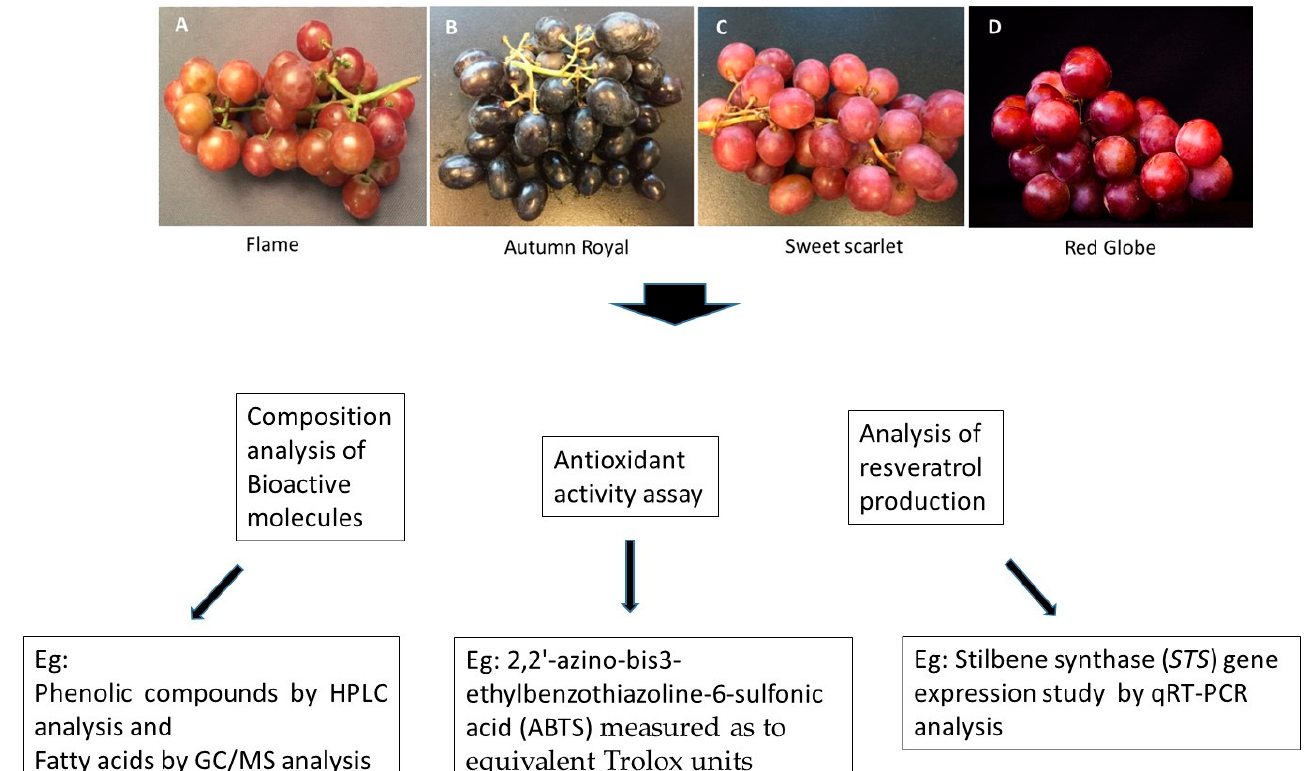
Figure 1. Schematic representation of the methods used in this study. Commercial table grape varieties tested from the Winnipeg market are ( A ) Flame, ( B ) Autumn Royal, ( C ) Sweet Scarlet and ( D ) Red Globe. Bioactive composition was analyzed using HPLC and GC/MS. Antioxidant activity was determined for all 4 varieties. Constitutive stilbene synthase gene expression on resveratrol production was also studied using quantitative real-time PCR (qRT-PCR) method.